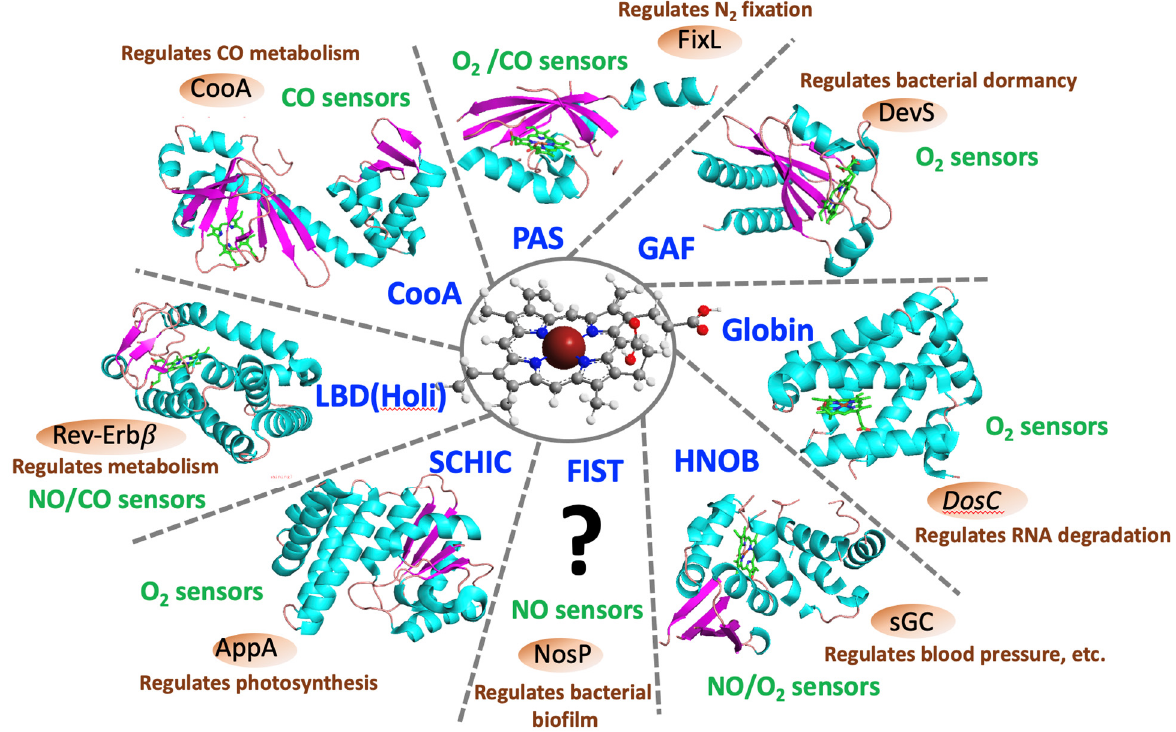
Figure 2. Heme-based gas sensor families, structural heme fold (in blue; PAS domain (pdb 1DP9), GAF domain (pdb 4YNR), globin domain (pdb 6OTD), HNOB domain (pdb 2O09), FIST domain (3D structure not solved yet), SCHIC domain (pdb 4HEH), LDB(Holi) domain (pdb 3CQV), CooA domain (pdb 2FMY)), common functionality as a gas sensor (green) and some examples of proteins of each family (brown oval) and biological function (brown).